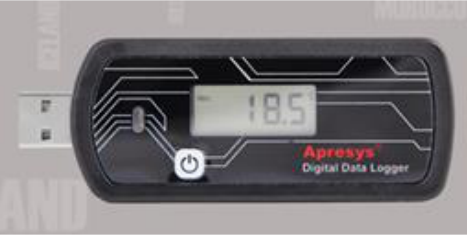
Figure 8. Temperature